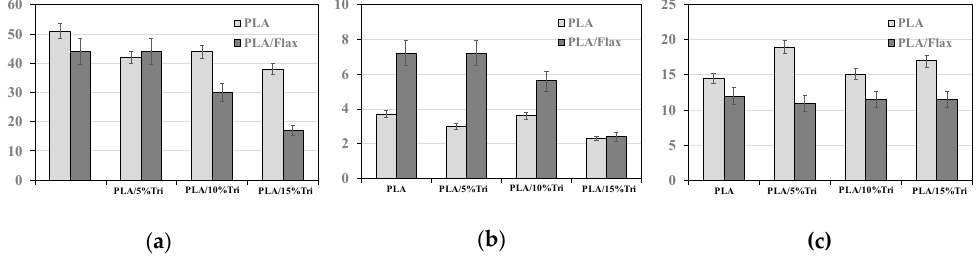
Figure 12. Mechanical properties: ( a ) tensile stress, ( b ) tensile modulus, and ( c ) unnotched Charpy impact strength of neat PLA and PLA/flax, without and with triacetin [50], Reproduced with permission from Oksman K, Compos. Sci. Technol.; published by Elsevier, 2003.